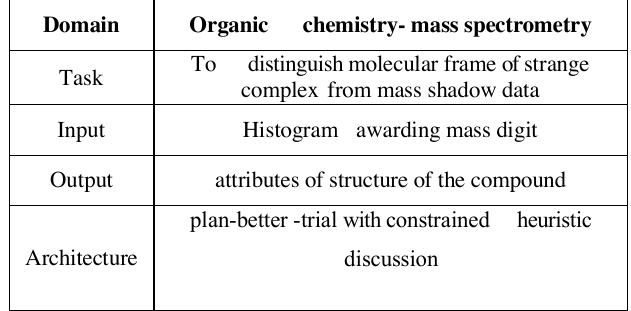
Table 1. Expert System compound